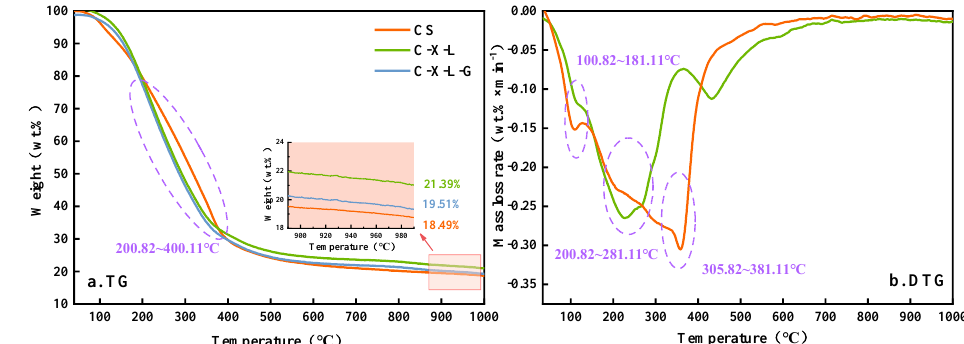
Figure 3. TG − DTG of multi-variate blending hydro-thermal bio-oils in different mono-component. The DTG curves of the four components (C-X-L-G) show the characteristics of partial cellulose + glycine (C-G) weight loss peaks, where they have three obvious indigenous weight loss peaks (100~181 ◦ C, 200~280 ◦ C, and 300~380 ◦ C), and their temperature range is consistent with that of the cellulose + glycine (C-G) weight loss peaks, but the weight loss peak rate increases in the temperature range of 200~280 ◦ C, and there are some three- component (C-X-L) peaks. Similar to the TG curves obtained by Lu et al. ‘s five-element hydro-thermal liquefaction blending model (cellulose, hemi-cellulose, lignin, lipid, and protein), the mass of the four components (C-X-L-G) all decreased rapidly within the range of 200~380 ◦ C [26]. The compounds situated in the temperature ranges of 100~181 ◦ C and 300~380 ◦ C are mainly produced by the interaction between cellulose and glycine, while the compounds in the temperature range of 200~280 ◦ C are mainly produced by the interaction of each mono-component. There are only two weight loss peaks (100~181 ◦ C and 300~380 ◦ C) in the DTG curve of the CS in the above temperature range, which is